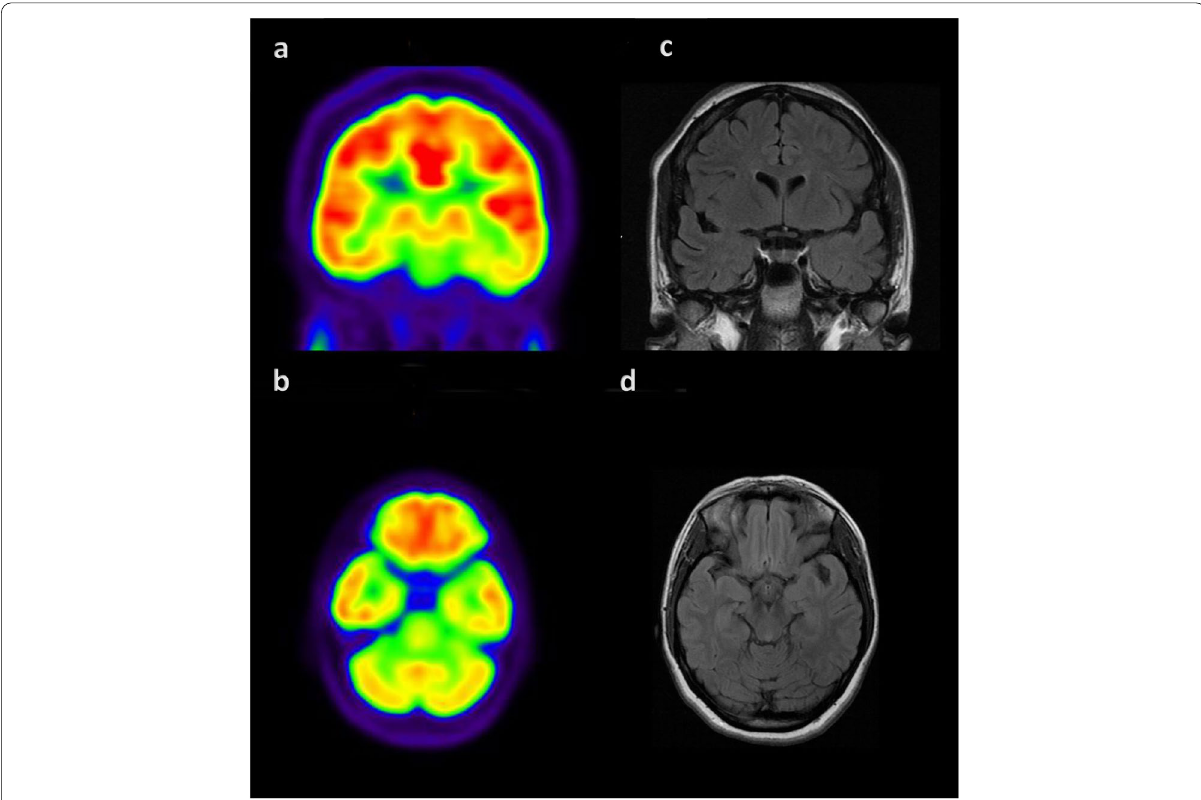
Fig. 2 Presurgical phase 1 imaging results. a . A coronal slice of brain FDG‑PET/CT imaging, in high‑contrast color scale, demonstrating reduced uptake in the left temporal lobe. b . An axial slice at the level of the temporal pole showing reduced uptake in the left temporal lobe. c , d . Coronal and axial T2 flair